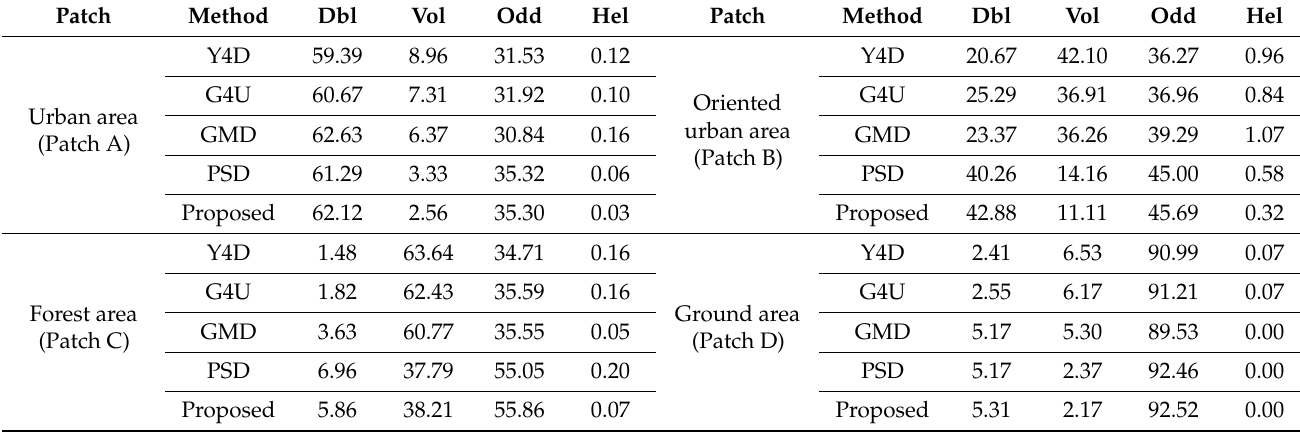
Table 1. The percentage of dominant scattering mechanism from the decomposition results of Pi-SAR data (%). Patch